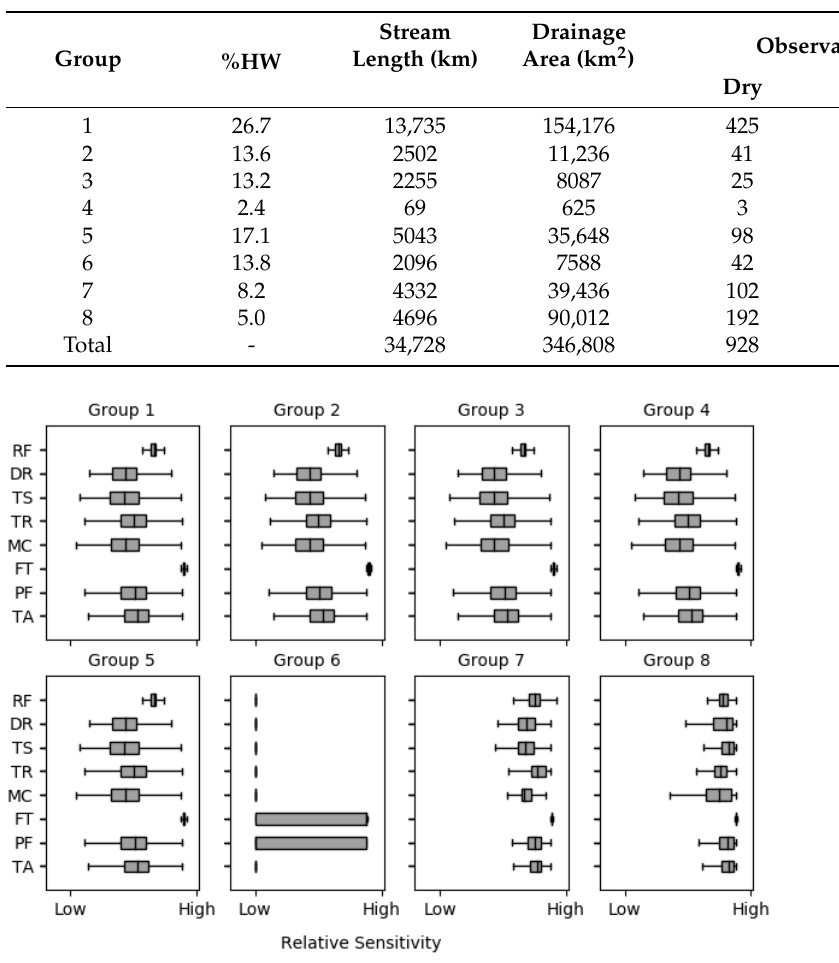
Figure 5. Distribution of relative parameter sensitivities for stream segments within each calibration group (Table 2).